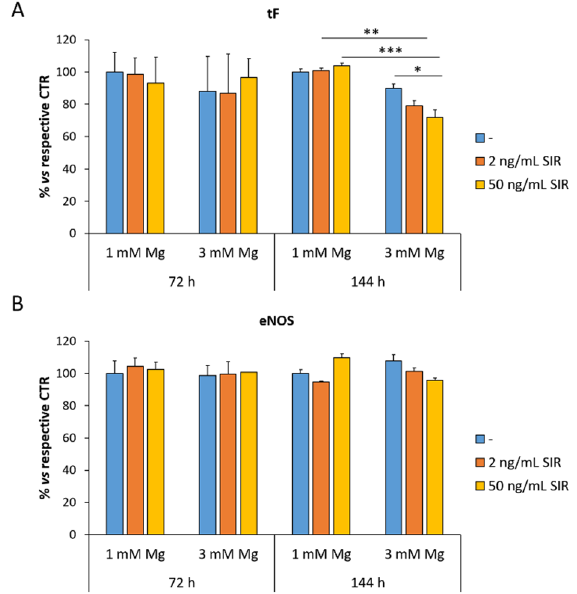
Figure 3. The effects of sirolimus and Mg on the total amounts of tF and eNOS. ELISA for tF ( A ) and eNOS ( B ) was performed as described above. Data are expressed as the mean ± standard deviation of three independent assays (* p ≤ 0.05; ** p ≤ 0.01; *** p ≤ 0.001).